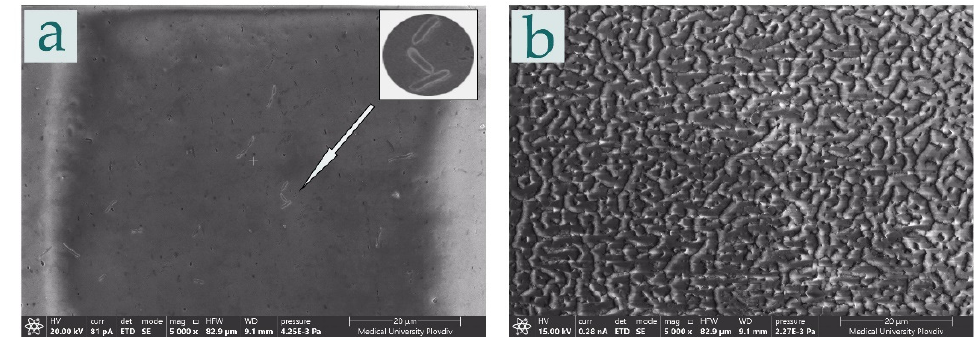
Figure 10. Microphotographs of sample groups ( a ) BT-6 and ( b ) BE-8 at ×5000 magnification.